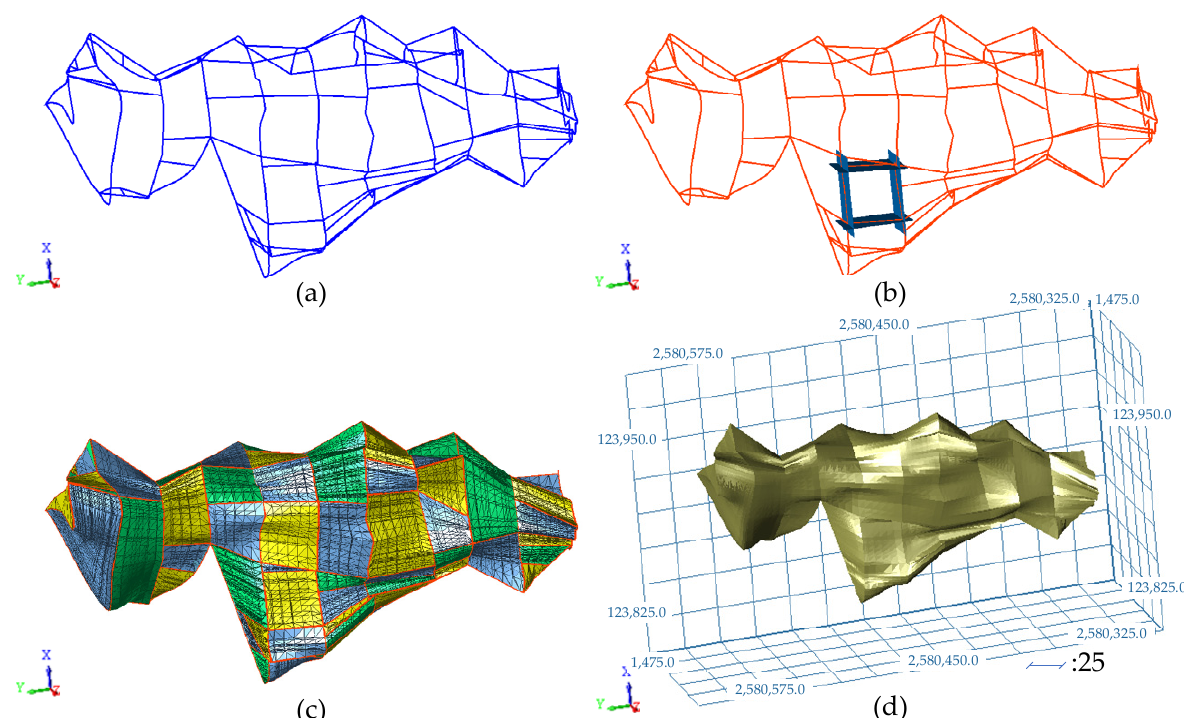
Figure 14. Experimental results of the third set of contour polylines: ( a ) the original contour polylines; ( b ) closed-loop division; ( c ) single closed-loop modeling; ( d ) sub-mesh combination.